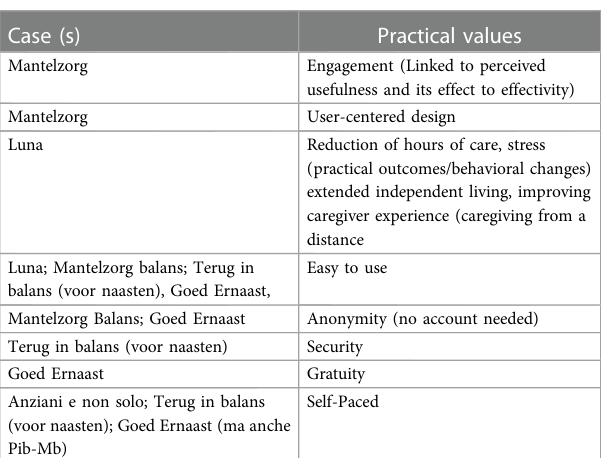
TABLE 3 Overview of practical